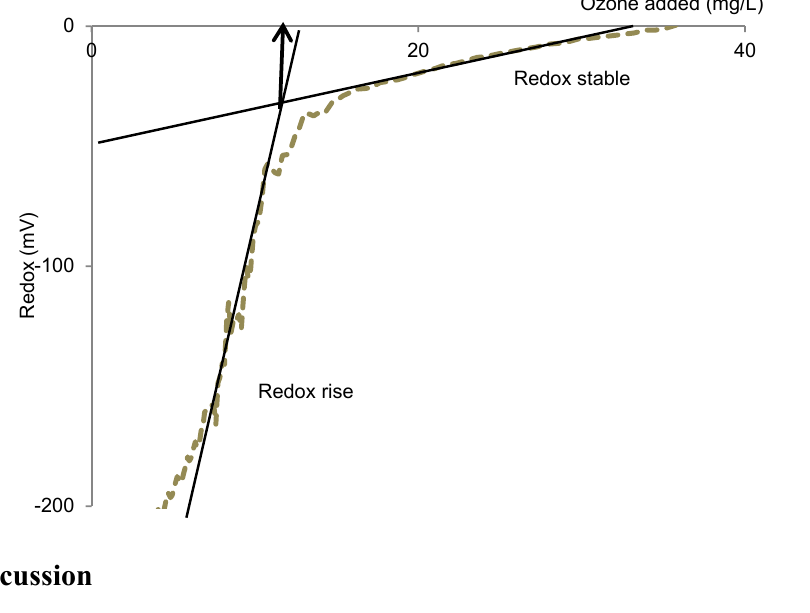
Figure 1. Estimation of ozone amount required for minimizing the H intercept of the linear regression for two of the observed redox phases: the redox rise and following relatively stable redox level. Example: manure